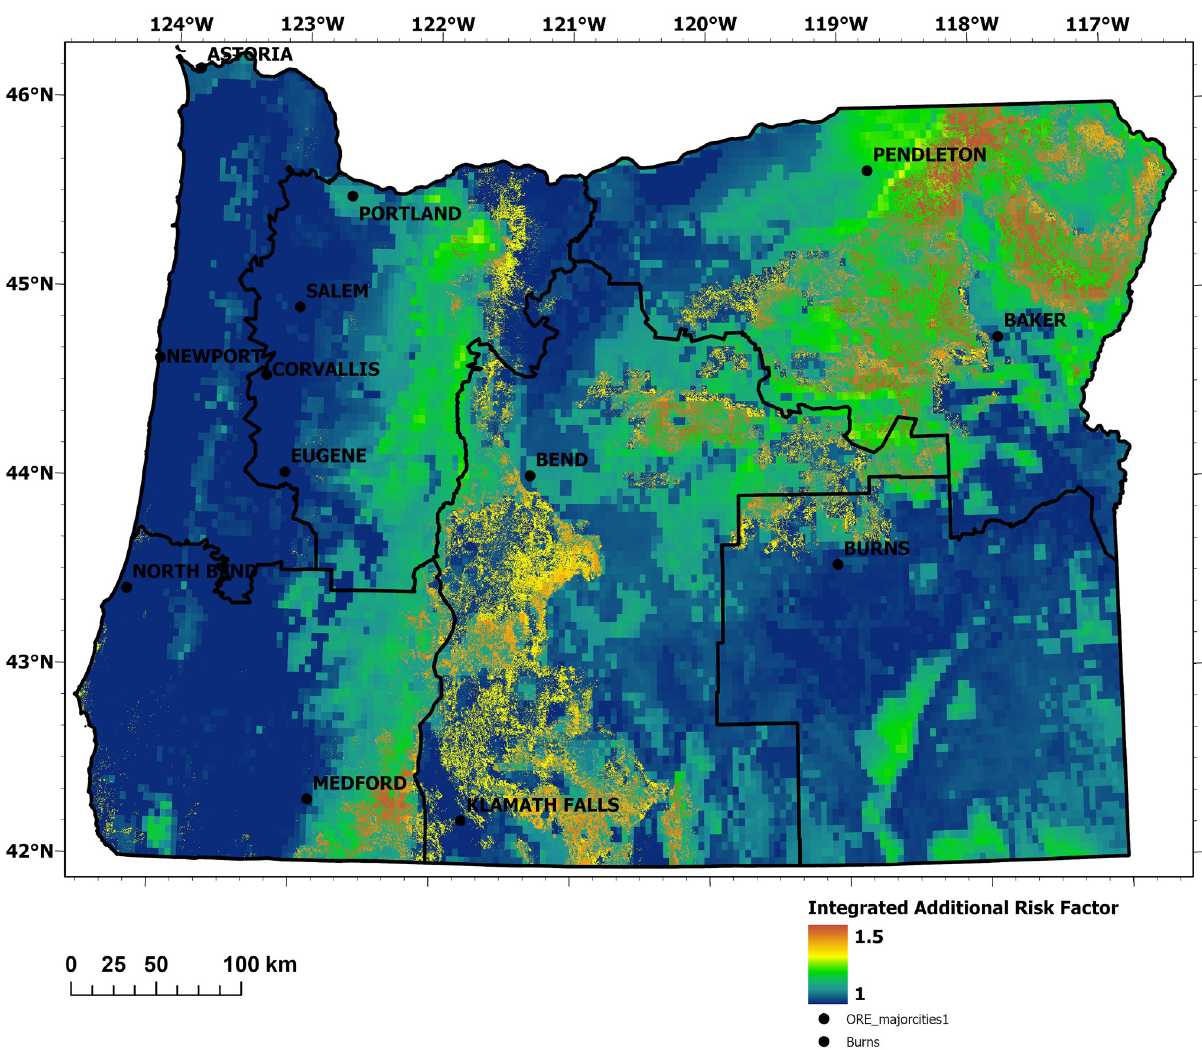
Fig 5. Spatial distribution of the IARF accounting for drought severity during the fire season, insect and disease infestation, and gorse occurrence.